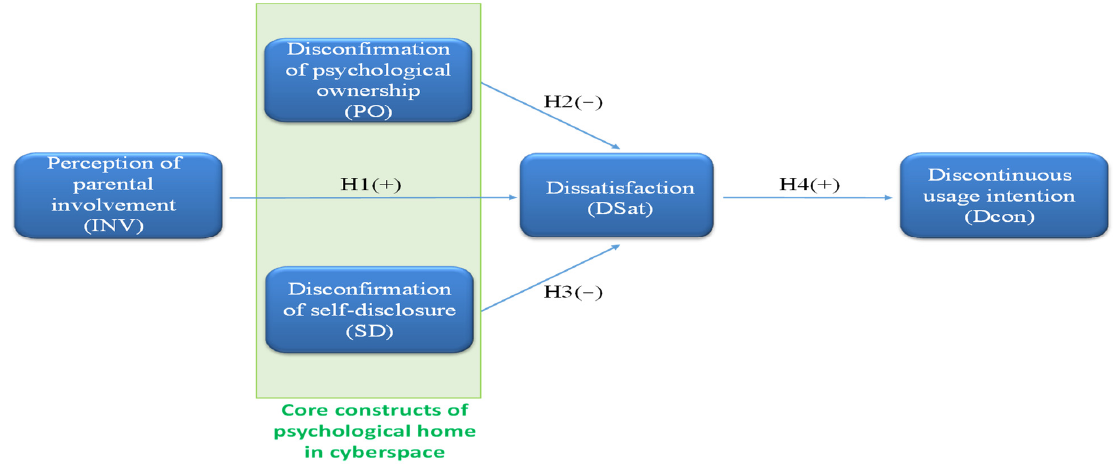
Figure 1. Research Model.